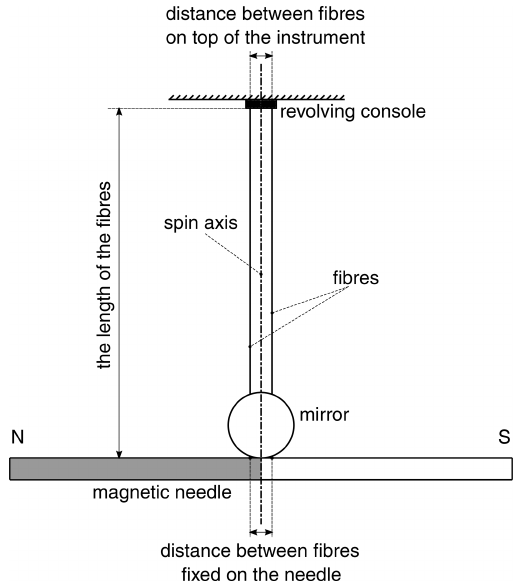
Figure 3. A sketch of the fibres, magnetic needle, and mirror in the bifilar